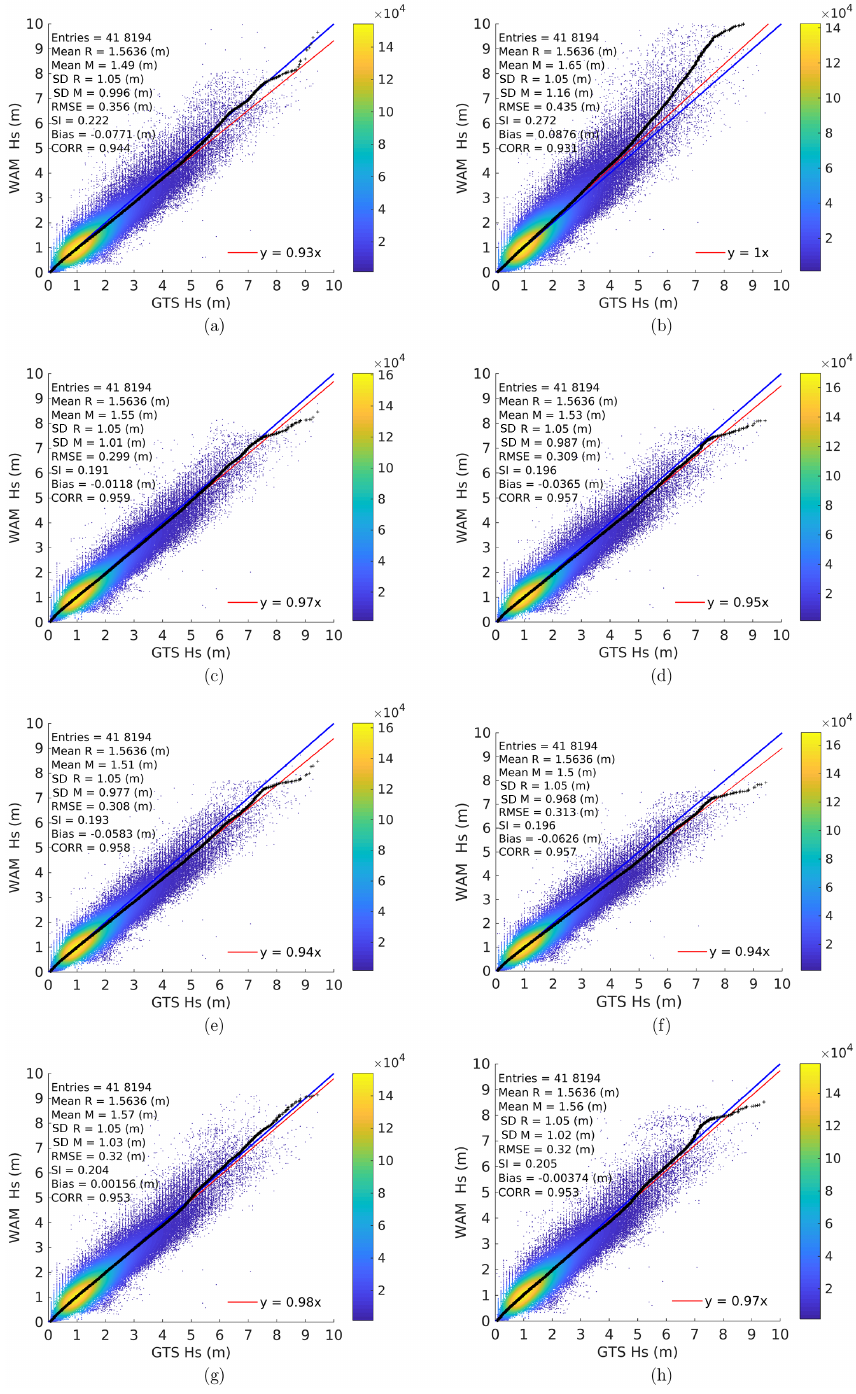
Figure 2. Q–Q scatter plot for measured (GTS wave data) significant wave height as reference (R) and modelled (WAM) significant wave heights (M) with (a) ERA-Interim, (b) coastDat-3, (c) hourly and (d) 6h ECMWF operational analysis/forecast; (e) hourly and (f) 6h ERA5; and (g) hourly and (h) 6h DWD forecast wind forcings from June to November 2016: Q–Q plot (black crosses), 45 ◦ reference line (blue line) and least-squares best-fit line (red